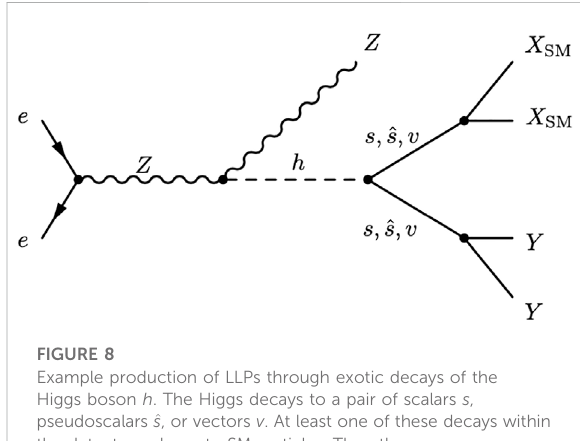
FIGURE 8 Example production of LLPs through exotic decays of the Higgs boson h . The Higgs decays to a pair of scalars s , pseudoscalars ^ s , or vectors v . At least one of these decays within the detector volume to SM particles. The other may or may not decay within the detector and may decay to visible or invisible